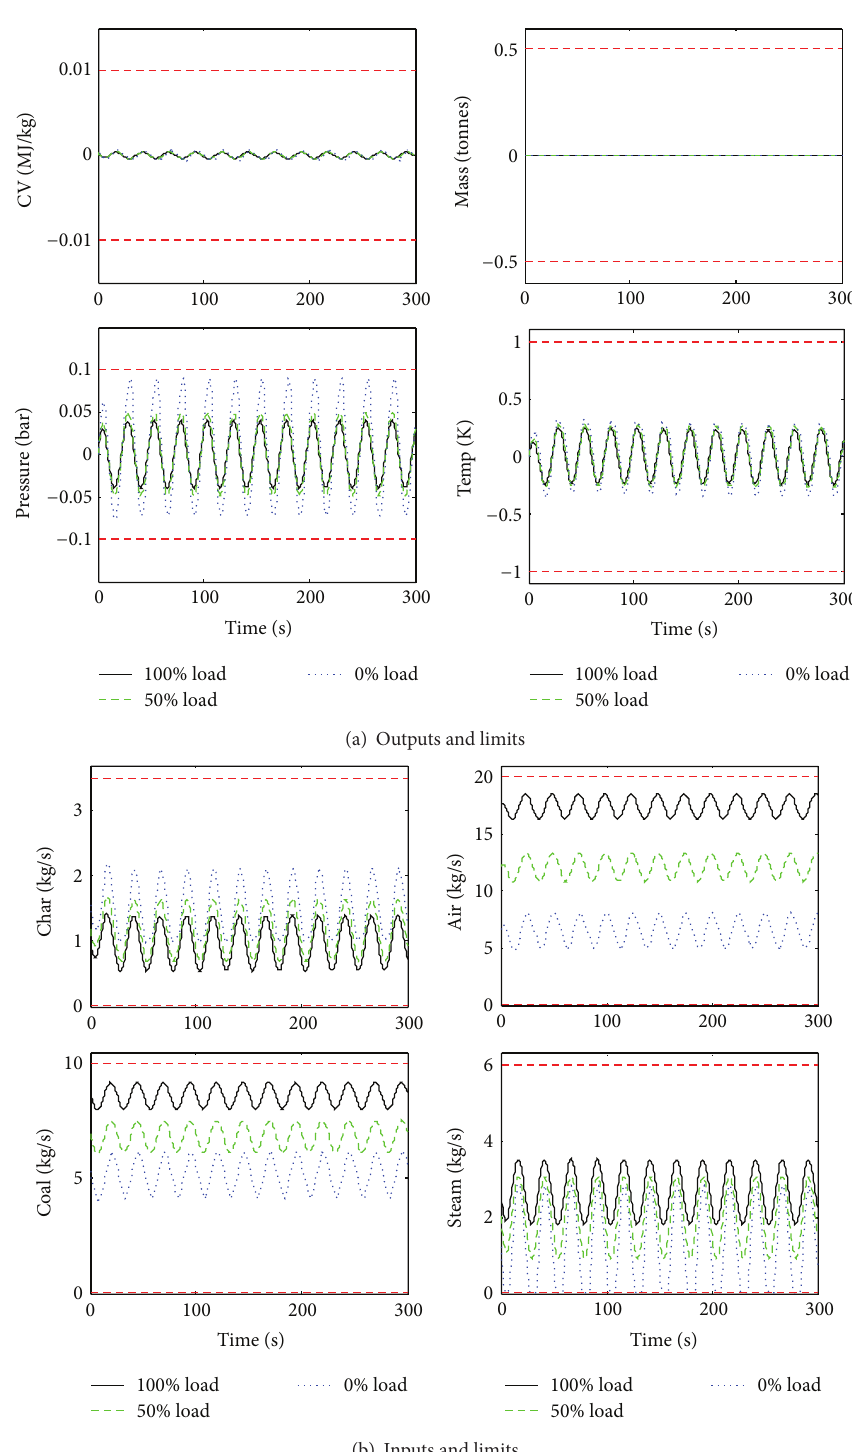
Figure 4: Response to sinusoidal disturbance at 0%, 50%, and 100%